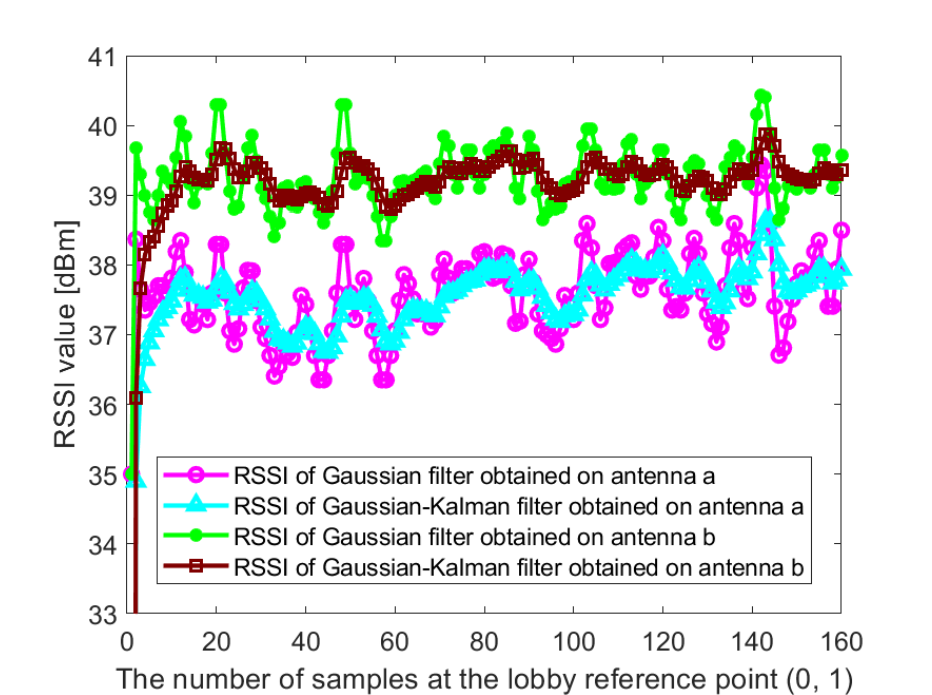
Figure 5. The Gaussian filtered RSSI value and the Gaussian-Kalman filtered RSSI value of AP1 on the effective antenna obtained at the reference point (0,1) in the lobby of IT2